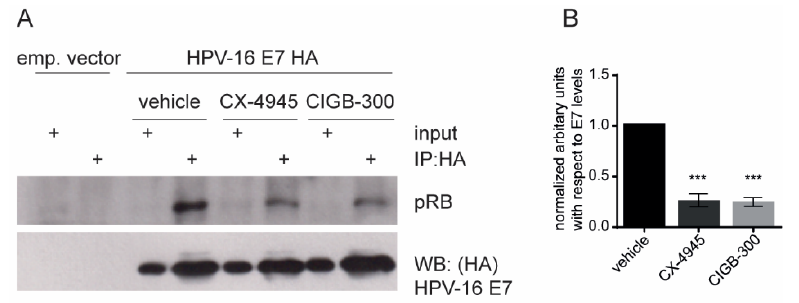
Figure 4. Effect of inhibiting CK2 activity on the E7–pRB interaction. HEK293 cells were transfected with the empty pCMV vector or with pCMV:FLAG-HA-HPV-16 E7. The cell lysates were immuno- precipitated using an anti-HA antibody immobilized on agarose beads. ( A ). The immunoprecipitated complexes were then washed with lysis buffer and analyzed by western blot for pRB and total E7. The panel shows the protein inputs and the results of the immunoprecipitation. ( B ). Quantification of the levels of immunoprecipitated pRB with respect to the levels of E7 in the presence of CK2 inhibitors. Data are shown as means ± SD, n = 3. Statistically significant differences between vehicle and drug treatment are indicated with *** p < 0.001, determined using one-way ANOVA followed by Dunnett’s post-test.